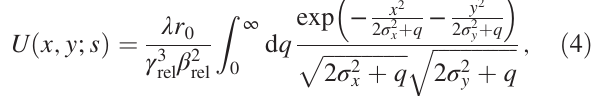
FIG. 12. Incoherent tunes in the NX22 experiment obtained by simulations. The vertical axis represents the bare tune and the horizontal axis represents the incoherent tune. Different actions have been plotted with different colors. The colors are the same as in Fig.